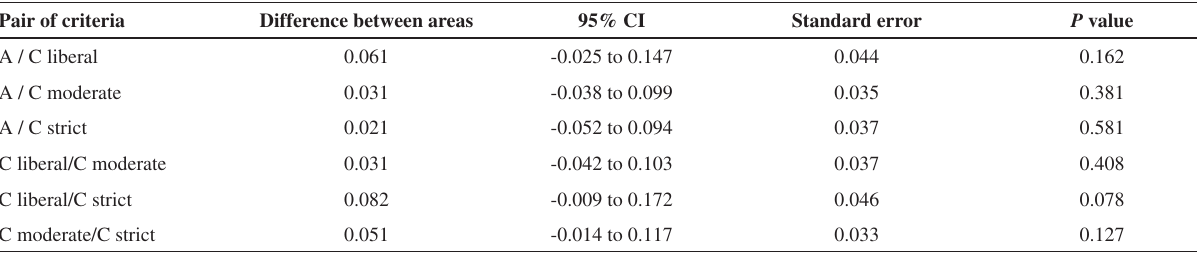
Table 4 - Pairwise comparison of ROC curves Pair of